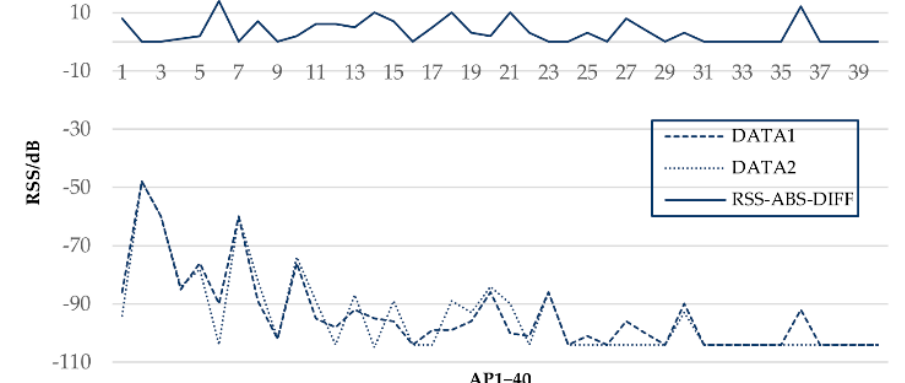
Figure 2. RSS difference of part AP (AP1 − AP40) at the same position.